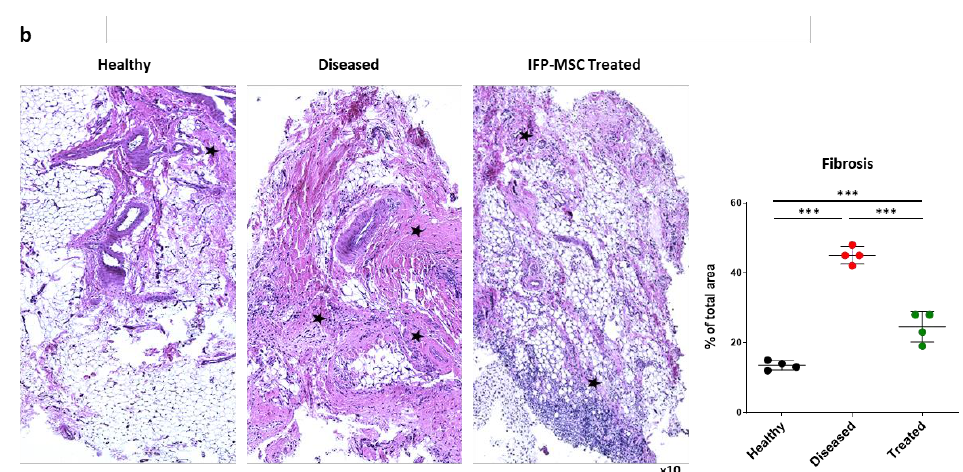
Figure 1. A rat model of induced acute synovitis and IFP fibrosis was used to understand IFP cellular heterogeneity and associated transcriptional programs. ( a ) Single-cell RNA-sequencing workflow for three groups (healthy, diseased, IFP-MSC treated). ( b ) H&E staining of IFP tissue revealed significant ( p < 0.05) reduction in IFP fibrosis 4 days after IFP-MSC administration (marked with asterisks) (*** p < 0.001). Statistical analysis was performed using non-parametric Kruskal–Wallis test.